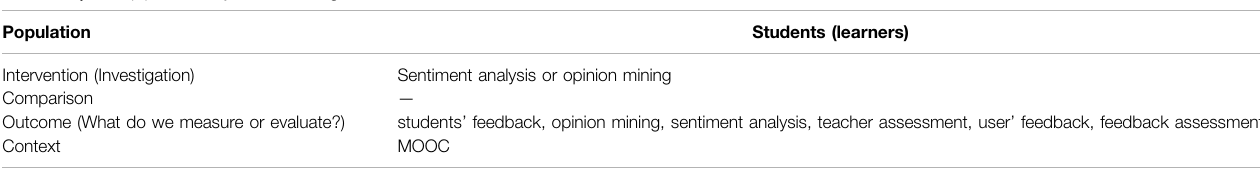
TABLE 1 | PICO(C) driven keywords framing.